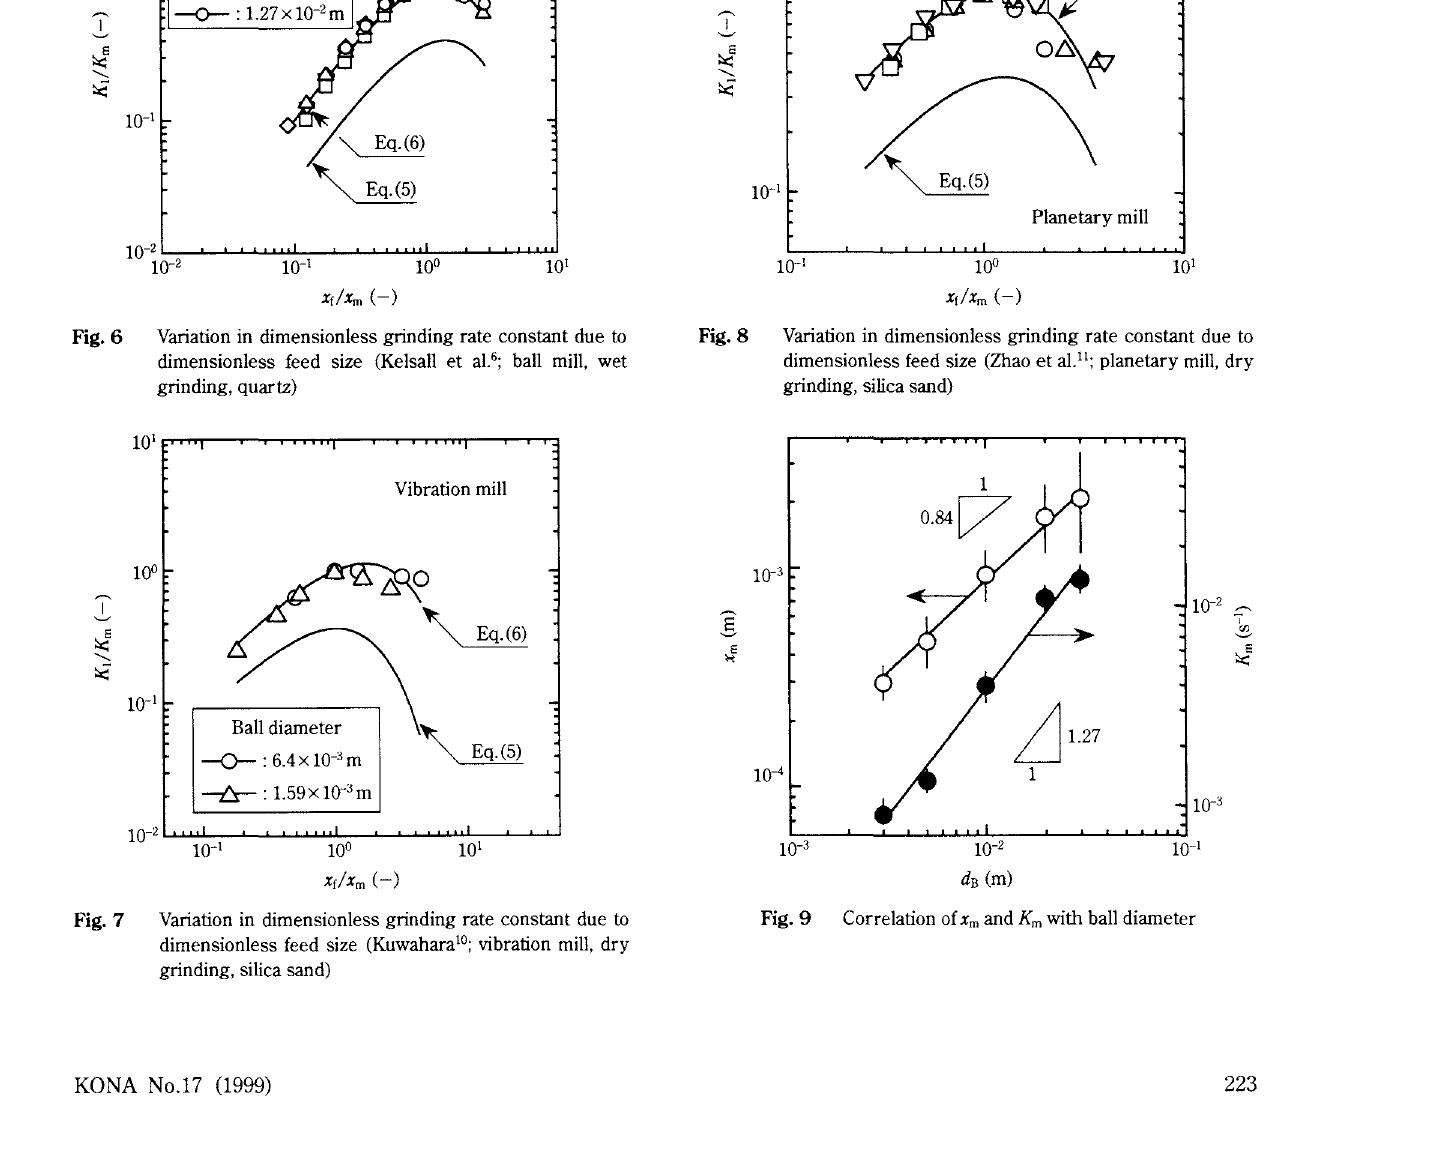
KONA No.17 (1999)